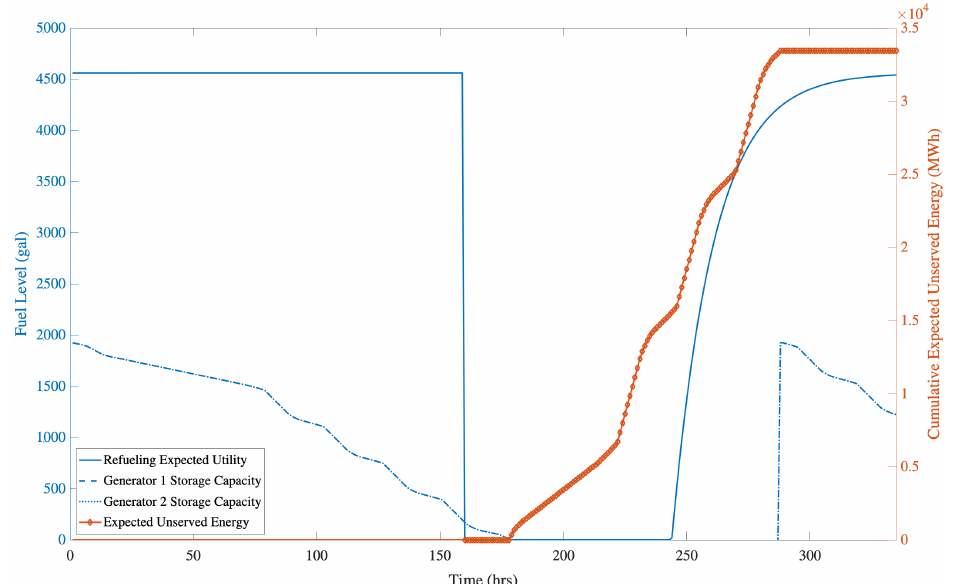
Figure 7. 72-h refueling disruption during islanded operation of current microgrid configuration. Two slaved 330 kW EDGs, each with 1925 gal storage capacity, support all critical loads after isolating from the utility grid. A SCN disruption occurs from t = 160 to t = 231, preventing weekly scheduled refueling at t = 168. The ripple effect reduces refueling expected utility (in gal) until normal operational capacity can be restored at t = 288. Critical loads are unmet from t = 178 to t = 287, approximating to 33.4 MW · h of EUE.